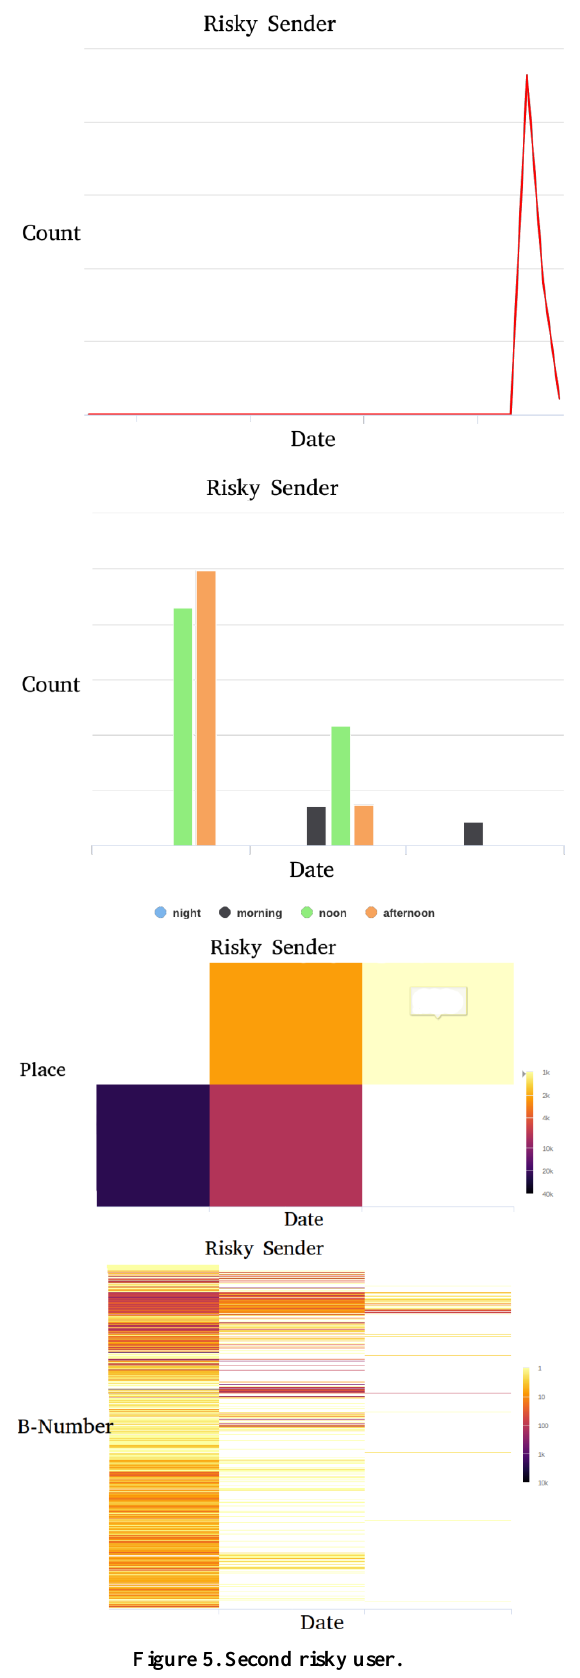
Figure 5. Second risky